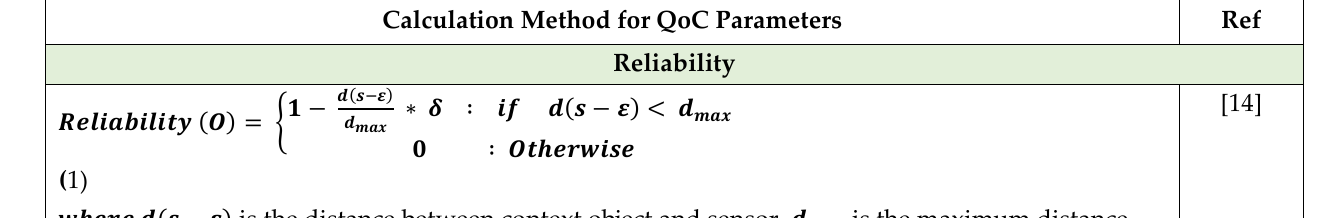
Table 4. Calculation of QoC